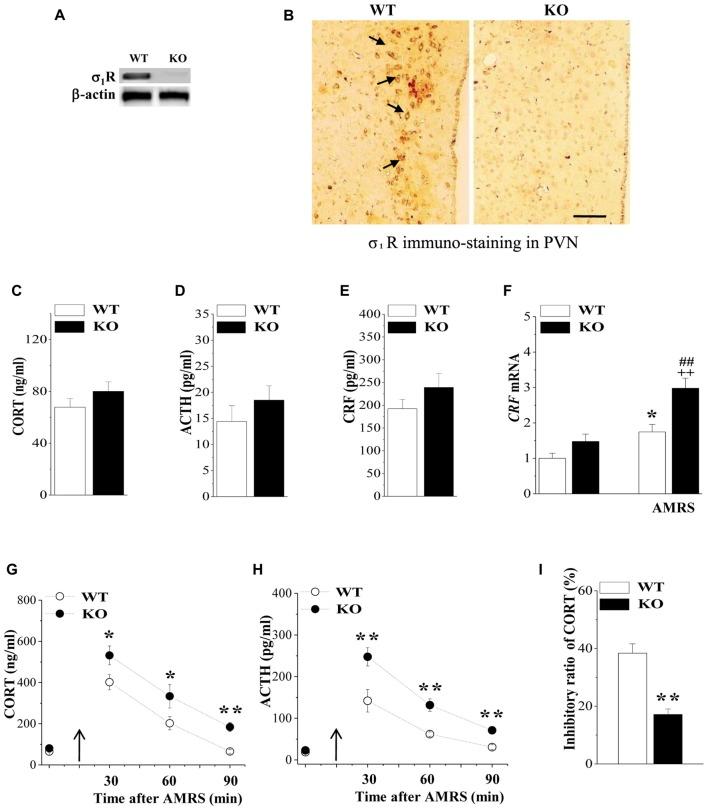
Expression of Sigma-1 receptor (σ1R) in paraventricular nuclei (PVN) and the activity of the hypothalamic-pituitary-adrenocortical (HPA) axis. (A) Representative blots of σ1R protein in the PVN of wild-type (WT) mice (WT) and σ1R knockout (σ1R-KO) mice (KO). (B) Representative photomicrograph of σ1R immunohistochemical staining. σ1R-positive principal neurons (arrows) in the PVN of WT mice. Scale bars = 25 μm. (C–E) Activities of the HPA axis in WT mice and σ1R-KO mice. Bar graphs show the basal levels of serum corticosterone (CORT), adrenocorticotropic hormone (ACTH) and corticotrophin releasing factor (CRF). (F) The levels of CRF mRNA under basal conditions or at 30 min after acute mild restraint stress (AMRS). *P < 0.05 vs. WT mice; ##P < 0.01 vs. σ1R-KO mice; ++P < 0.01 WT mice-subjected to AMRS (two-way analysis of variance (ANOVA)). (G,H) Each point represents the level of serum CORT or ACTH after AMRS. A solid arrow indicates the time of the AMRS exposure. *P < 0.05 and **P < 0.01 vs. WT mice-subjected to AMRS (repeated-measures ANOVA). (I) Bar graphs show the reduced level of CORT and ACTH at 6 h after the injection of dexamethasone (Dex; 0.1 mg/kg) compared to those at 48 h before the injection (basal levels). The inhibitory ratio was calculated with the following formula: (levels after Dex injection/basal levels) × 100. **P < 0.01 vs. WT mice (t test).